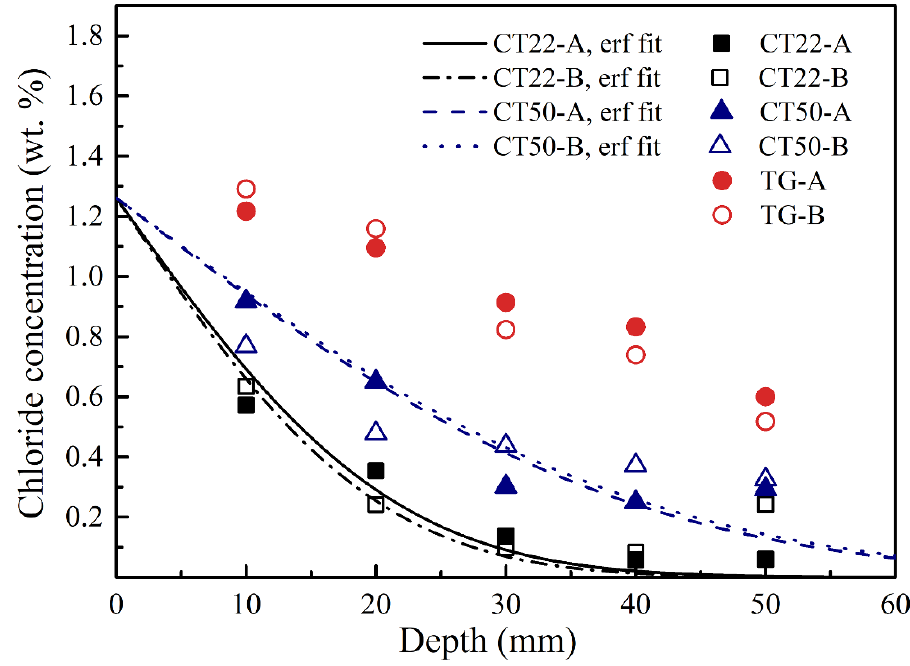
Figure 4. Fitted curves of chloride concentration profile to error function solution of Fick’s second law of diffusion with C s = 1.261 wt. %. (Single-column fit). Table 3. Apparent diffusion coefficients of concrete: D Cl and residual sum of squares, S R estimated with the method of least squares fit.